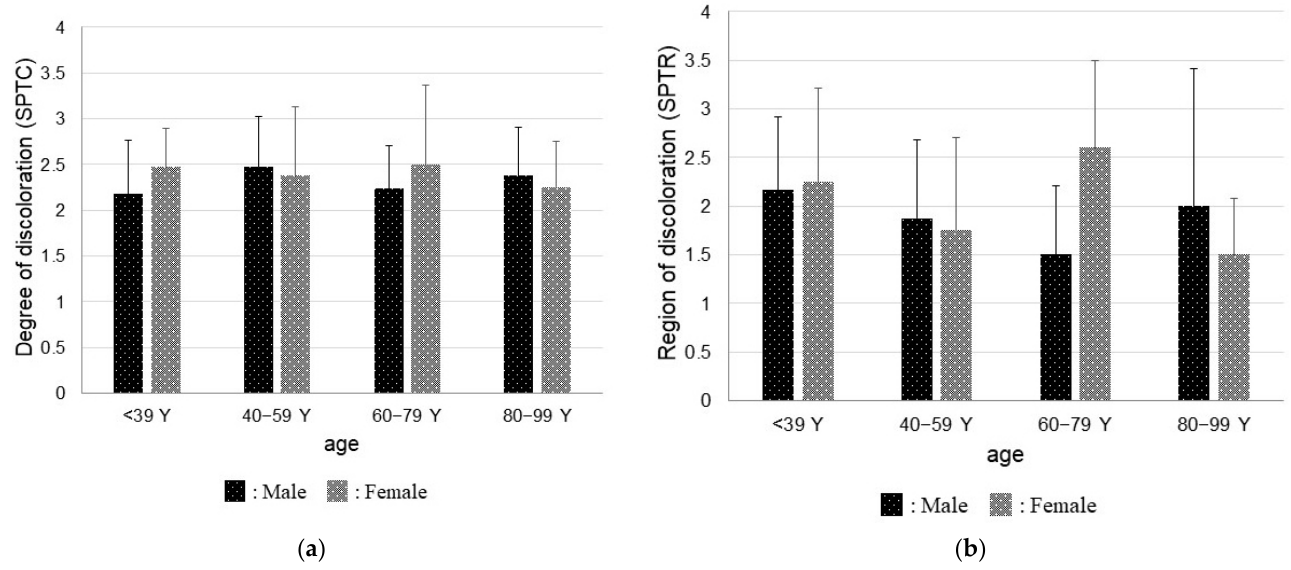
Figure 3. Associations of SPTC ( a ) and SPTR ( b ) according to sex for four age ranges (51 cases, n = 2–16). There were no significant differences for either score. SPTC, Score of Pink Teeth Color; SPTR, Score of Pink Teeth Region.